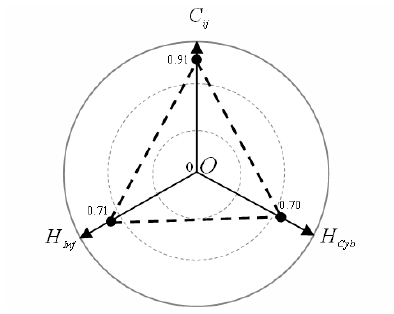
Fig. 6. Circular chart for the synergistic effect assessment of the e - th element for the interaction 11